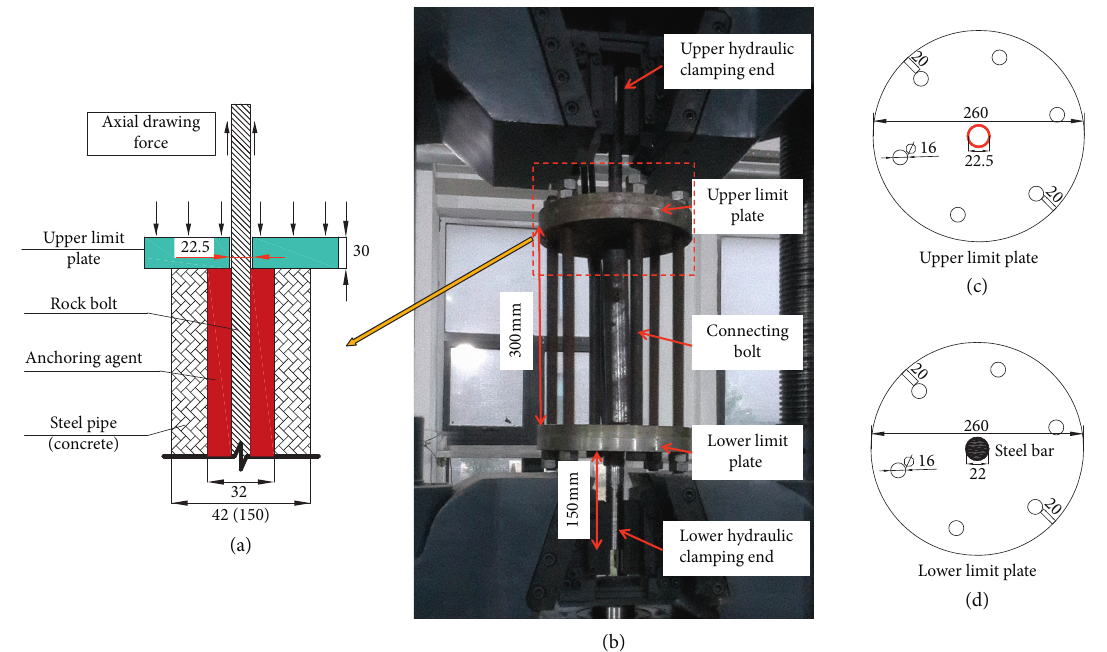
Figure 4: Structure of pull-out test tool (unit: mm).